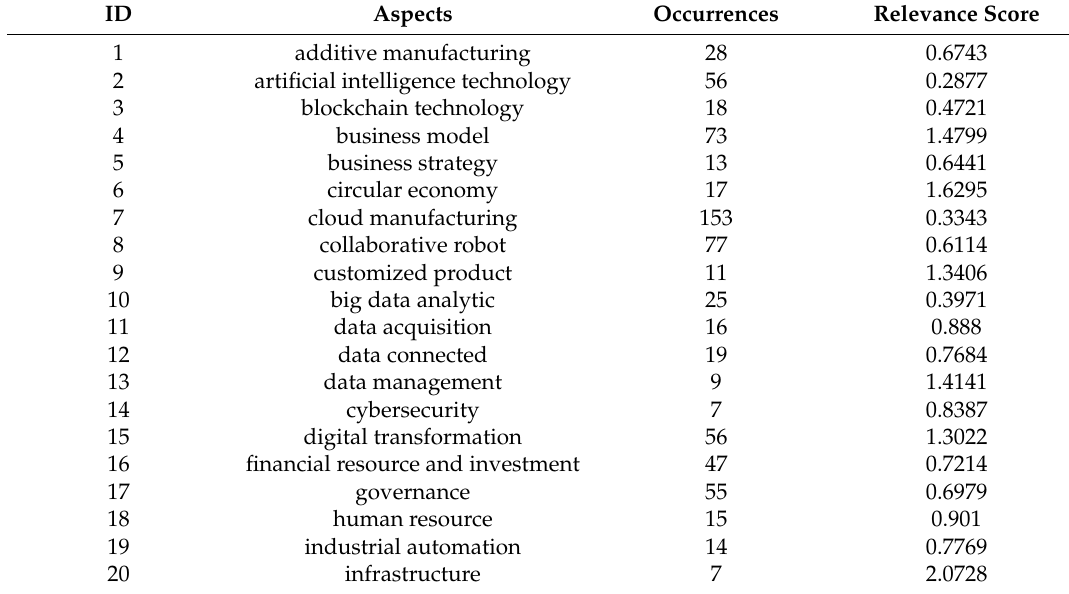
Table 4. Industry 4.0 Aspects selection keywords from the visualization of similarities